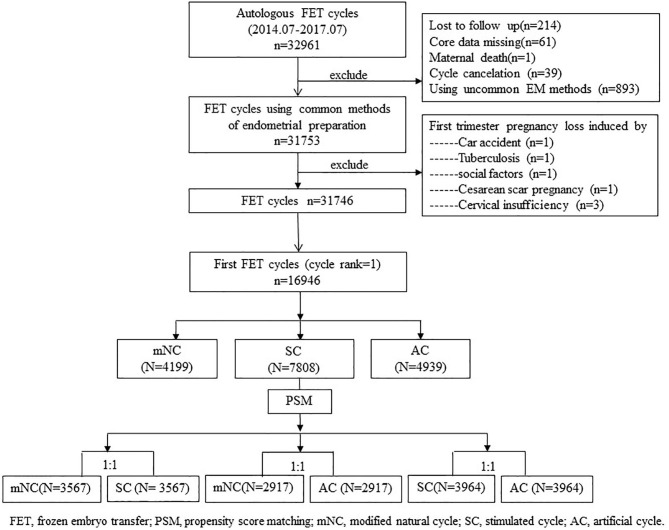
Patient inclusion flowchart.